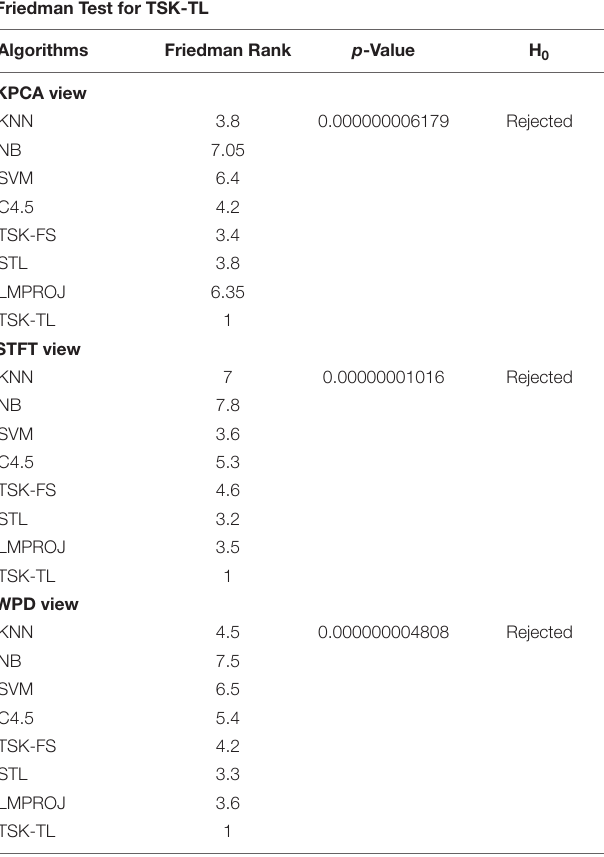
TABLE 8 | Holm’s post hoc comparison of the results of Friedman procedure of TSK-TL and other seven methods Holm’s post hoc comparison for TSK-TL